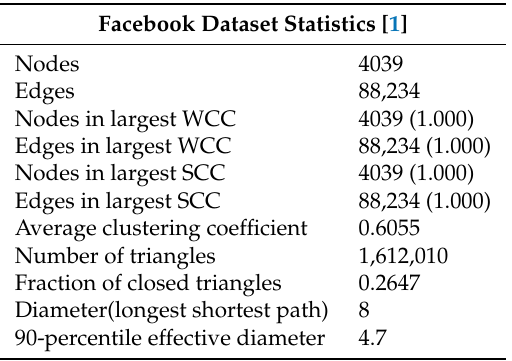
Table 1. Information of dataset used in VizTract with Strongly Connected Components (SCC) and Weakly Connected Components